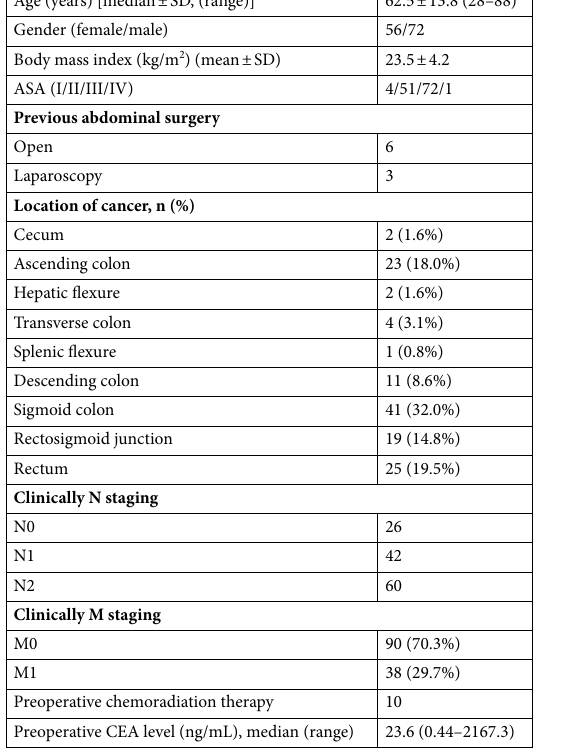
Table 1. Demographic and clinical data of patients (N = 128). BMI body mass index, ASA American society of